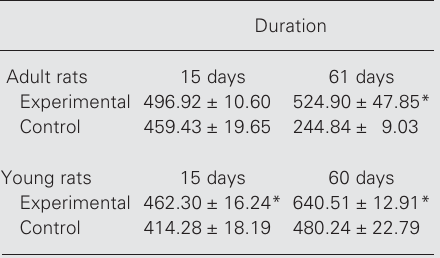
Table 3. Effect of hyperprolactinemia induced by domperidone on the cell area of zona fasciculata cells from adult and young